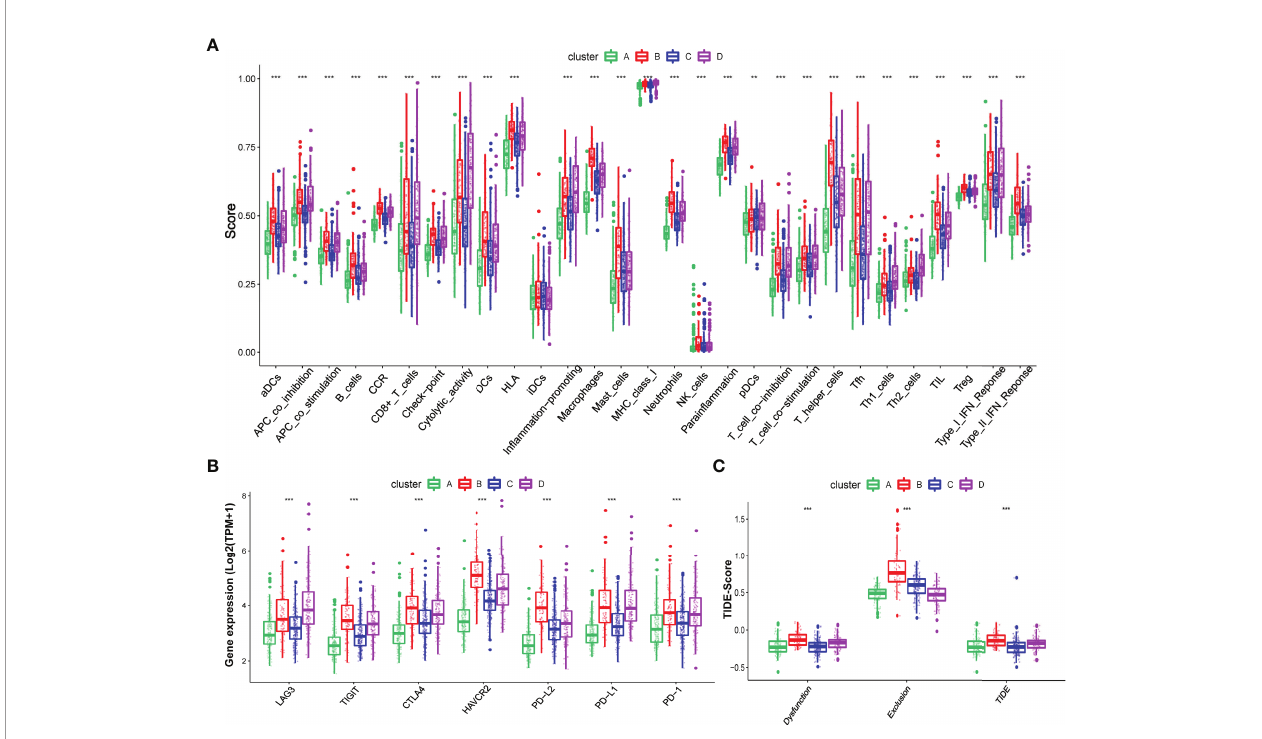
FIGURE 3 | Different immune characteristics in these fourhypoxiaclusters. (A) Different activation of immune functionsamongthese fourhypoxia clusters. (B) Different expressions of immune checkpoints among these four hypoxiaclusters. (C) Different TIDE scores amongthesefourhypoxia clusters. ( p < 0.05 *; p < 0.01 **; p < 0.001